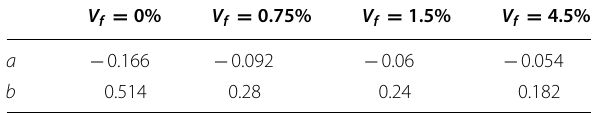
Table 4 Values of parameters a and b .